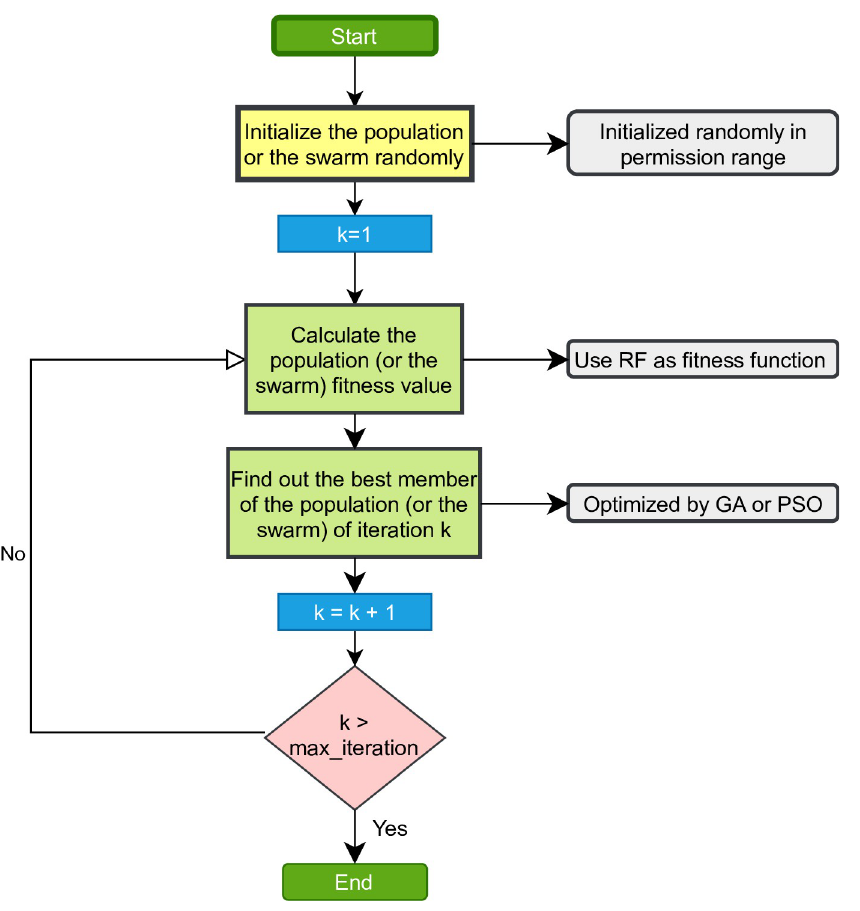
Fig 7. The flowchart of hybrid RF